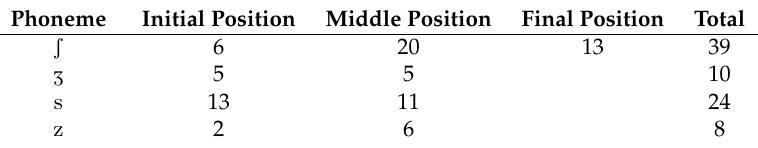
Table 2. Words with